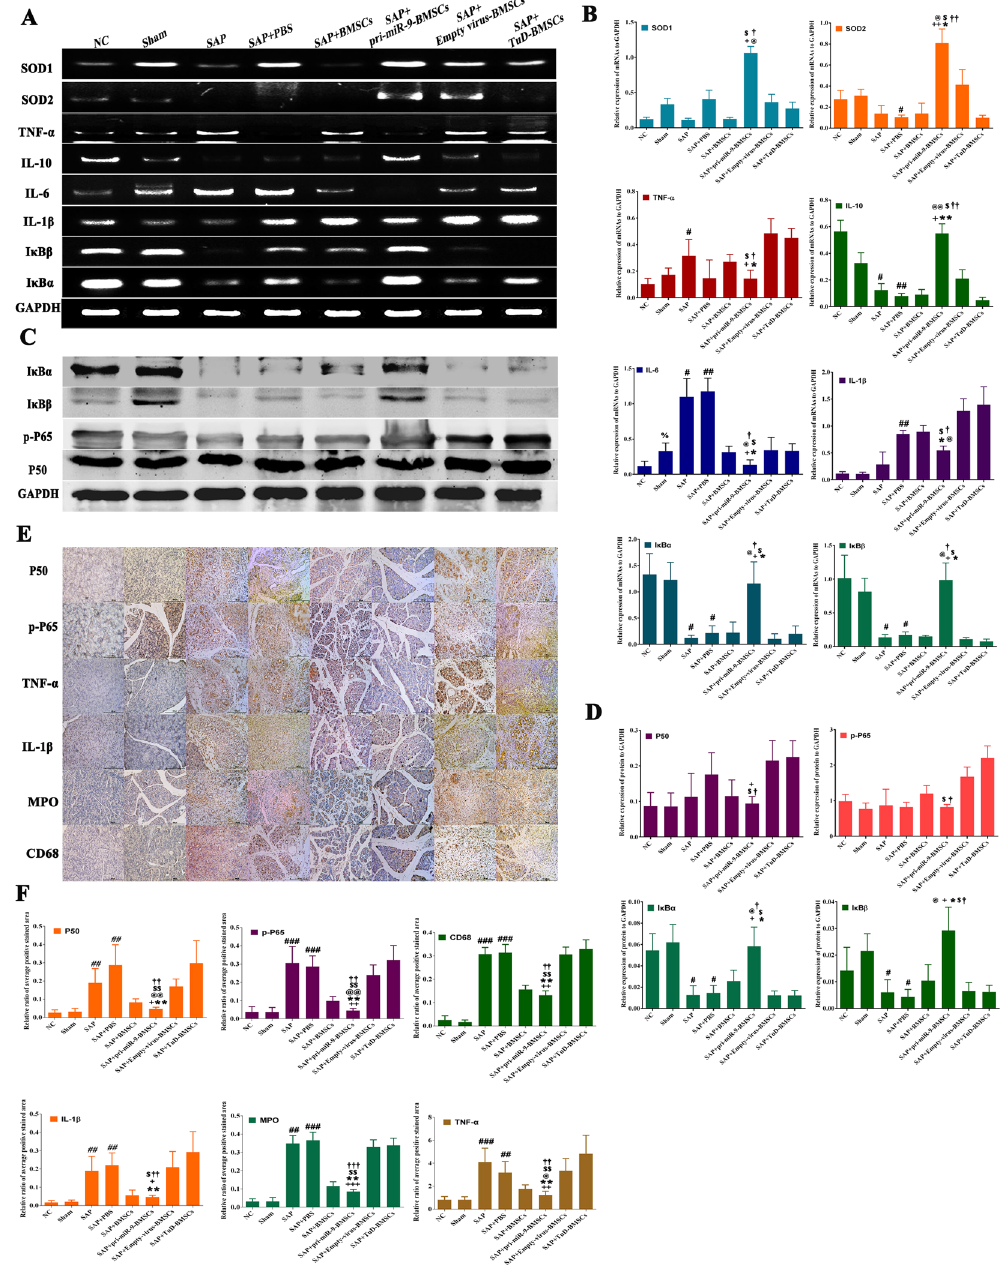
Figure 3. pri-miR-9-BMSCs could inhibit the local inflammatory response. The expressions of pro- inflammatory cytokines(IL-1 β , IL-6, TNF- α , and MPO), NF- κ B proteins (p-P65, P50) and CD68 were significantly decreased by pir-miR-9-BMSCs. On the contrary, the expressions of superoxide dismutase (SOD 1 and SOD 2 ) and anti-inflammatory proteins (I κ B α and I κ B β ) were significantly increased by pir-miR-9-BMSCs, compared with SAP, SAP + PBS, BMSCs, or TuD-BMSCs groups by gPCR ( A,B ), Western-blot ( C,D ) and IHC ( E,F ). Data are shown as mean ± SD for at least 3 separate experiments. %% P < 0.01, compared with NC, # p < 0.05, ## p < 0.01 and ### p < 0.001, compared with NC, + p < 0.05, ++ p < 0.01 and +++ p < 0.001, compared with SAP, * p < 0.05 and ** p < 0.01, compared with SAP + PBS, @ p < 0.05 and @@ p < 0.01, compared with BMSCs, $ p < 0.05 and $$ p < 0.01, compared with Empty-virus BMSCs, † p < 0.05, †† p < 0.01 and ††† p < 0.001, compared with TuD-BMSCs by using paired t test. gPCR, General PCR, IHC,